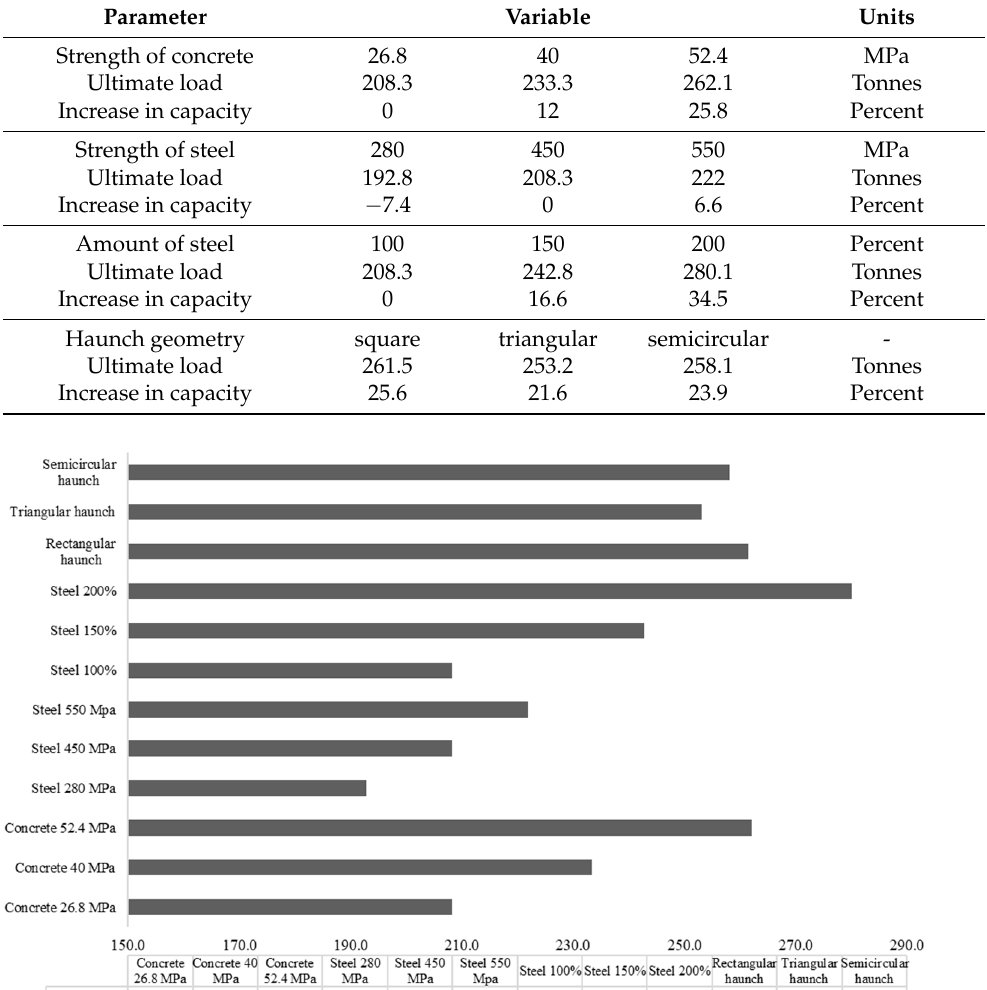
Table 5. Results of parametric analysis.